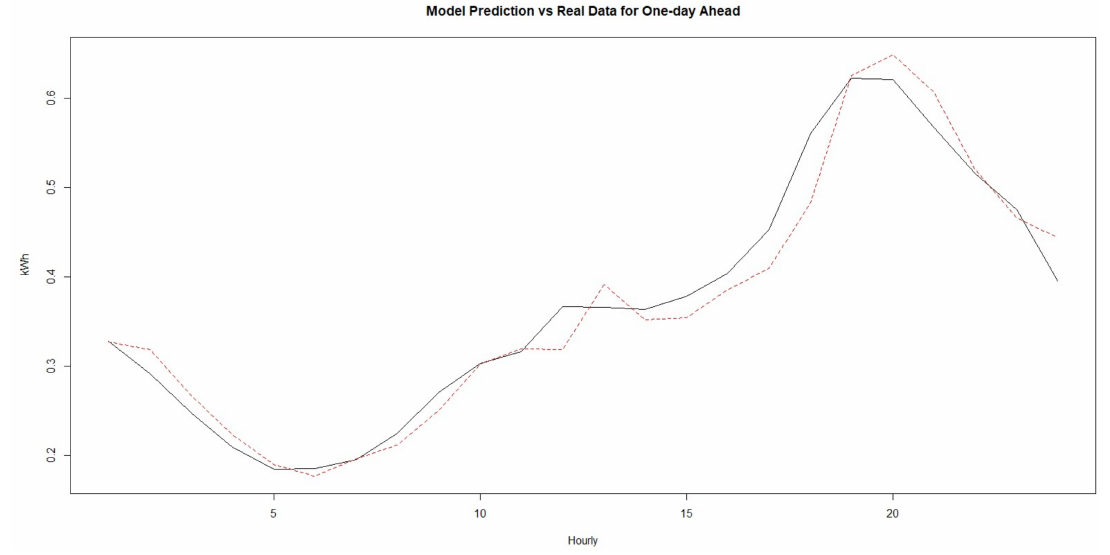
Figure 9. Model prediction with optimization (red line = prediction value, black line = real